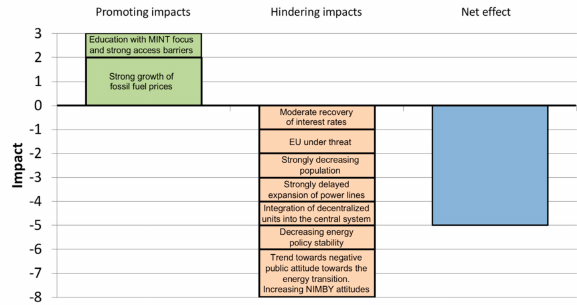
Figure 4. Disassembly of the impact sum of indicator “Cooperatives” into single impacts referring to descriptor variants (scenario INERTIA). Red components refer to negative, green components to positive impacts.